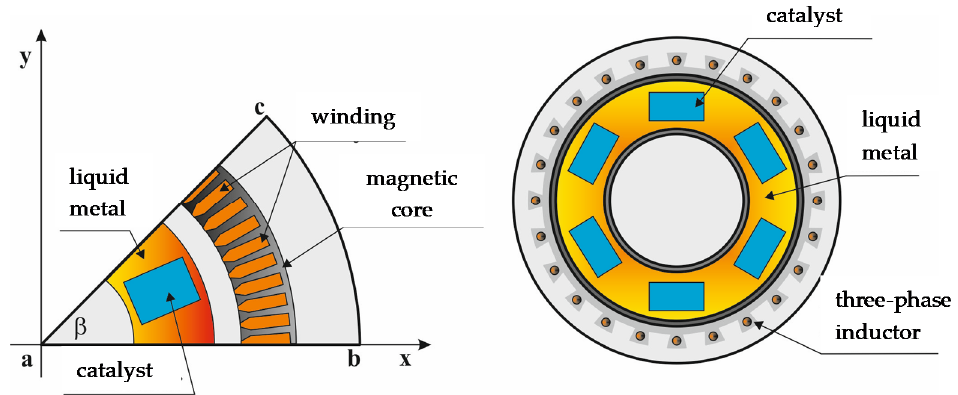
Figure 3. Calculating model used in the determination of processing parameters for collector metal method with magneto-hydrodynamic (mhd) pump; a, b, c are the vertices of the channel segment that was selected for numerical analyzes—due to the geometric and electrical symmetry of the system, the model was limited to 1/8 of the entire device.